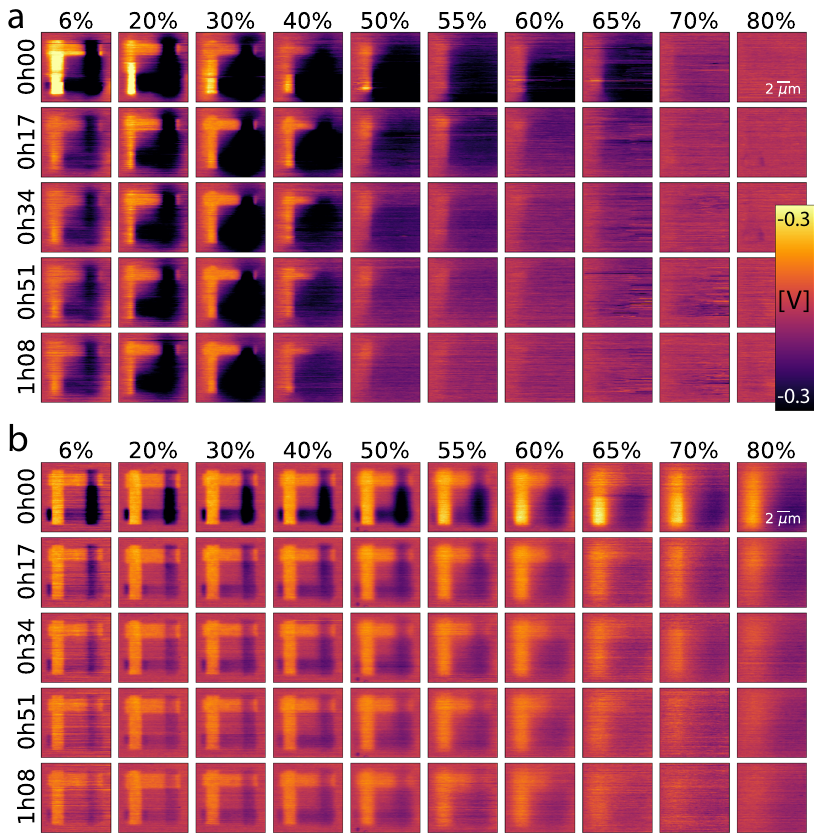
Fig. 2 KPFM contact potential difference imaging. The fi rst fi ve images from the complete humidity dataset are shown as a function of time and humidity for the ( a ) down-polarised and ( b ) up-polarised samples. A new structure is written at each relative humidity setpoint and then monitored continuously until complete contact potential difference signal dissipation. At low humidities the charges seem to be more localised and retained longer than at high humidities. Additionally, at higher humidities the horizontal lines corresponding to the fi rst writing step are not visible, suggesting much faster charge dynamics in presence of high water content at the surface. Lastly, the written pattern remains visible in the up-polarised fi lms at much higher humidity levels than in the down-polarised fi